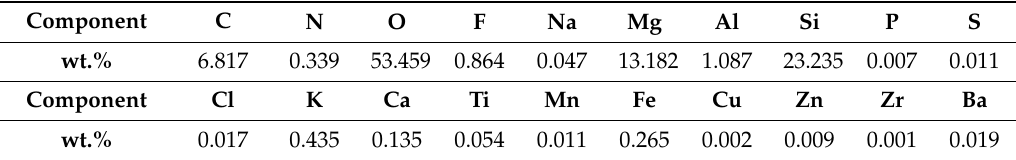
Figure 1. ( a ) PXRD patterns and ( b ) FTIR spectra of sepiolite and the spent sepiolite after photocatalytic degradation in various organic dye compounds. Table 1. The elemental compositions of sepiolite in